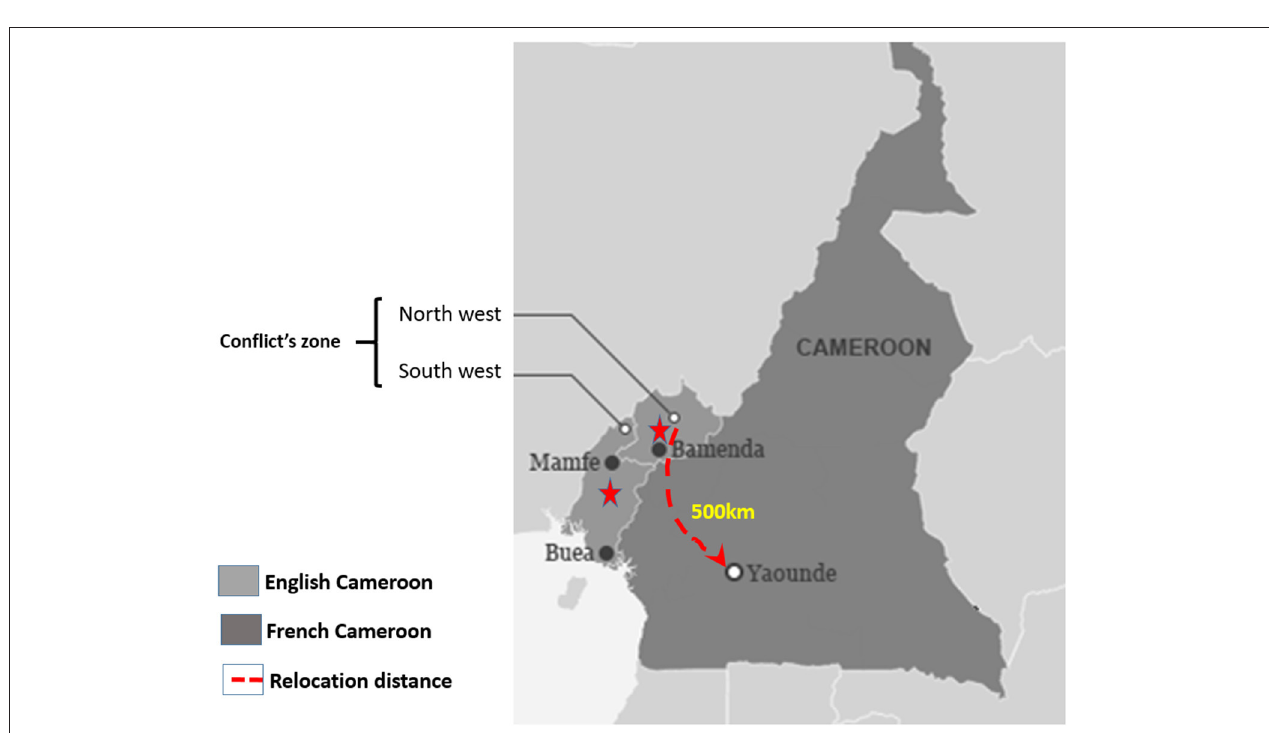
FIGURE 2 | Geographic illustration of the location of the cardiac centre of Shisong (CCS) and the successive relocation site.